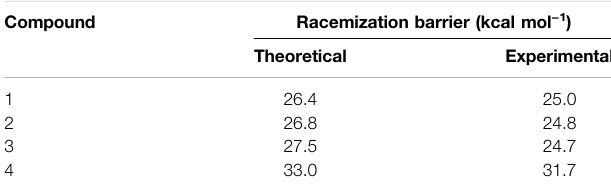
TABLE 1 | DFT (PBE0-D3/Def2-TZVP) and experimentally determined barrier for the racemization of banisters 1 – 4. Compound